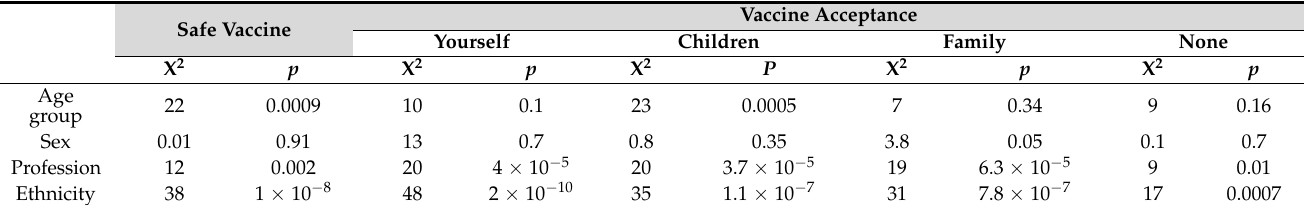
Table 4. Statistical significance of relationship between sociodemographic attributes, vaccination acceptability, and its